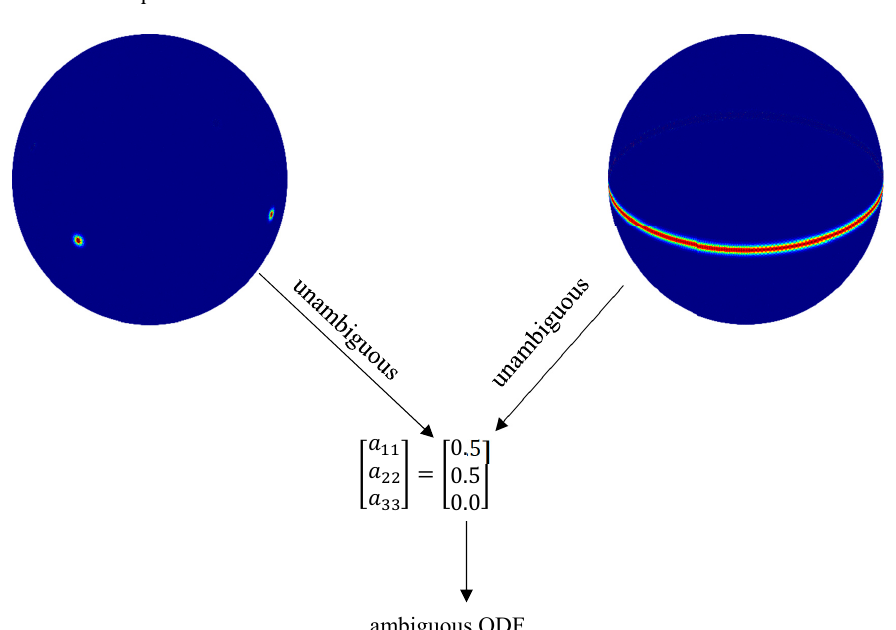
Figure 2. Two different orientation density functions (ODFs) (left: unidirectional with two maximas, right: planar isotropy) with the same fiber orientation tensor to illustrate the ambiguity of the reconstruction.